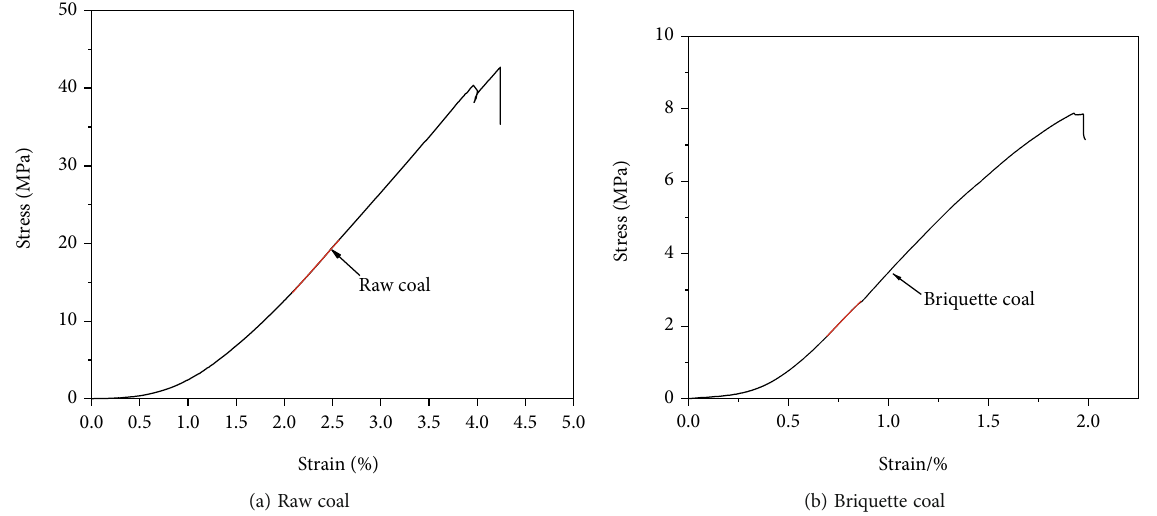
Figure 3: Stress-strain curves of raw coal and briquette